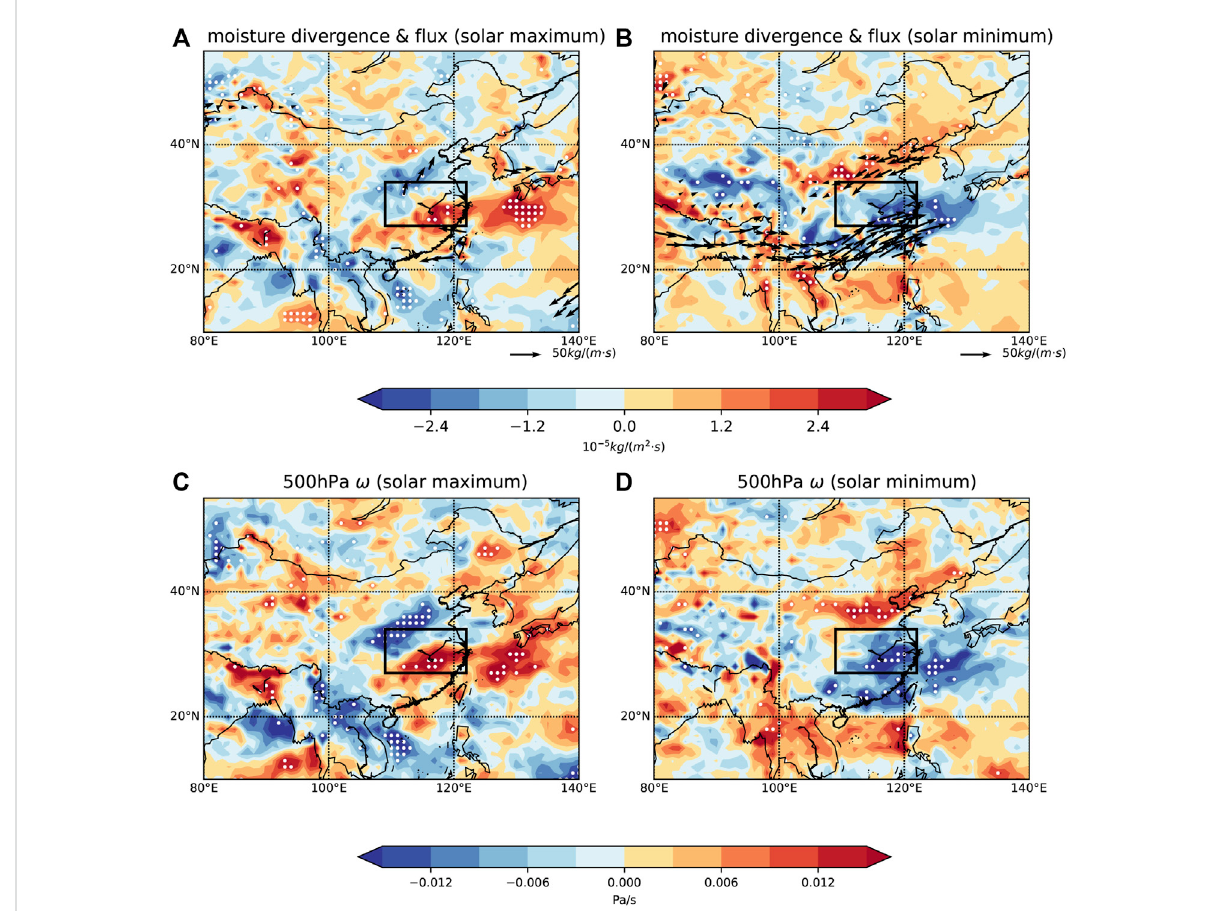
FIGURE 4 Composite map of vertically integrated (from 1,000 to 300 hPa) moisture fl ux (arrow) with its divergence (colored) in solar maximum (A) and in solar minimum (B) . Composite map of 500 hPa atmospheric vertical velocity ( ω ) in solar maximum (C) and in solar minimum (D) . The moisture fl ux divergence in red/blue represents divergence/convergence. The ω in red/blue represents descending/ascending motion. White dotted regions and the black arrows indicate signi fi cant correlations satisfying the 95% con fi dence level. The range of the MLRYR (rectangle) is consistent with Figure